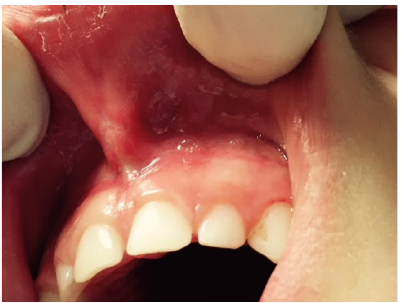
Figure 7. Labial frenulum treated by laser frenectomy after healing.